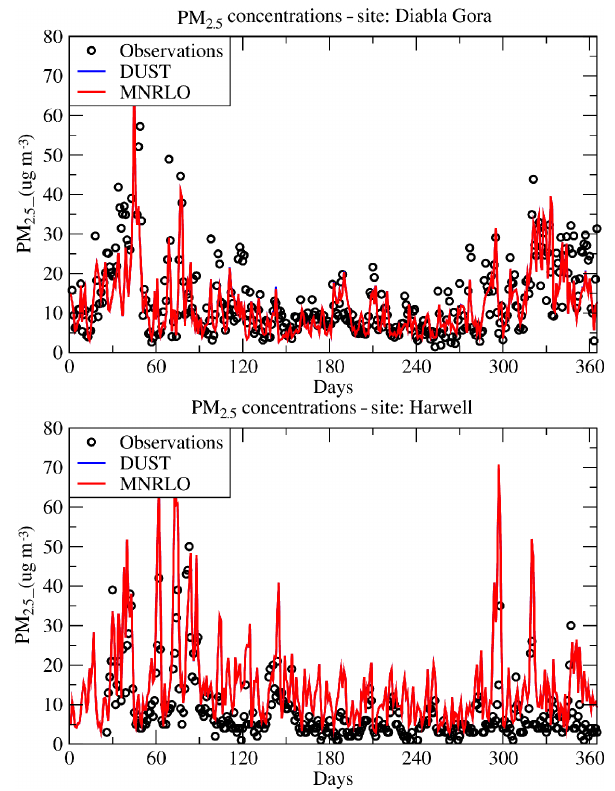
Figure 6. Daily averaged surface concentrations of PM 2 . 5 with the EMEP measurements and the two CHIMERE simulations, DUST and MNRLO.